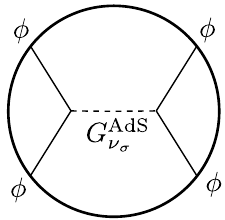
Figure 15 . Exchange diagram in EAdS. Using the spectral representation of the bulk-to-bulk propagator G AdS , and then the split representation of the harmonic function, one readily obtains ν σ the expansion of the four-point function of φ in the basis of conformal partial waves, eq. (6.4).